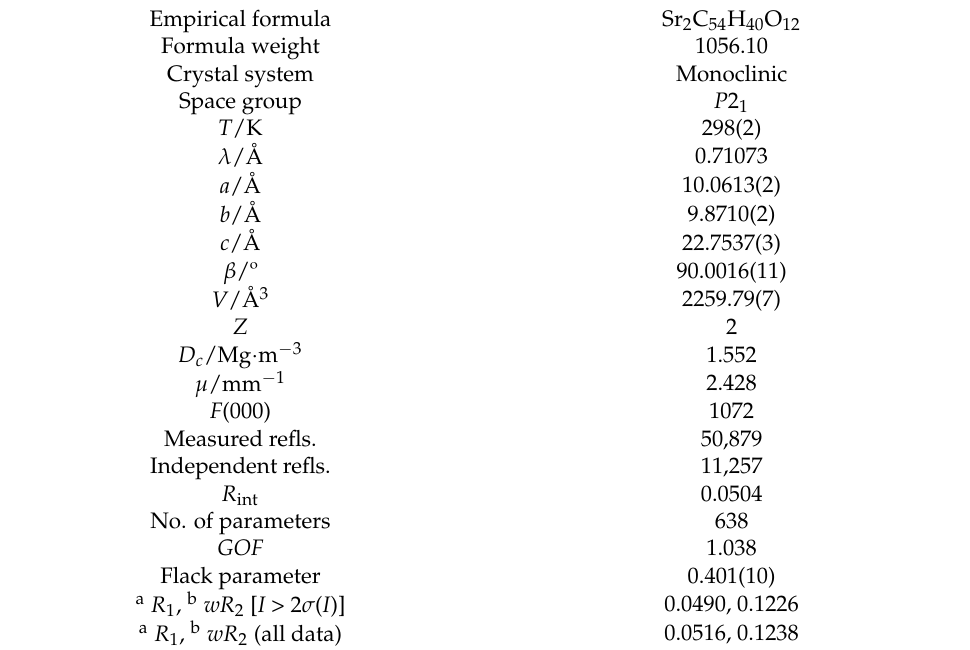
Table 1. Crystallographic data and structural refinement details for Sr 2